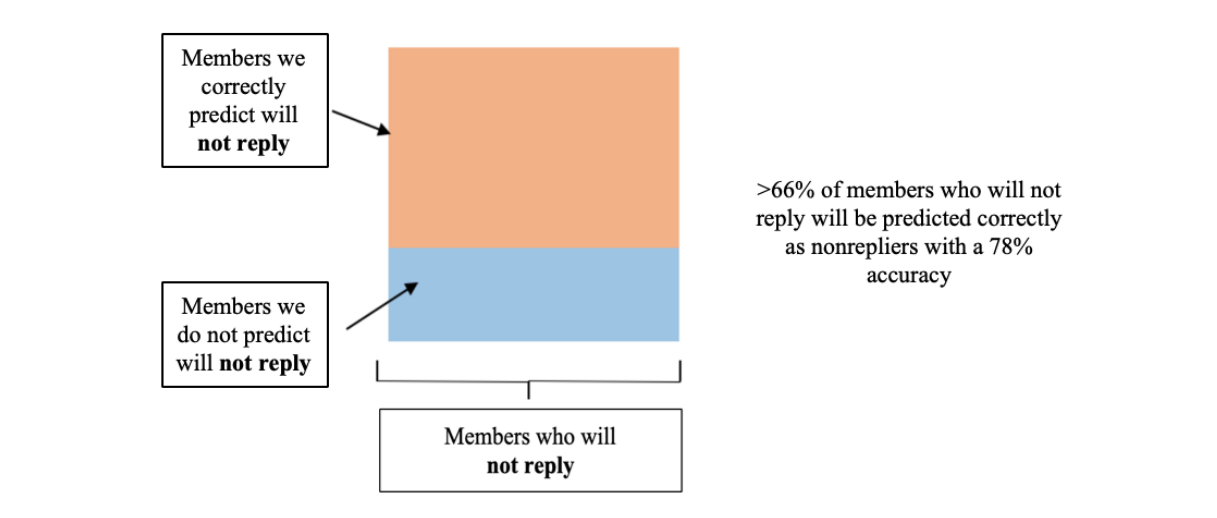
Figure 7. Minimizing the number of false